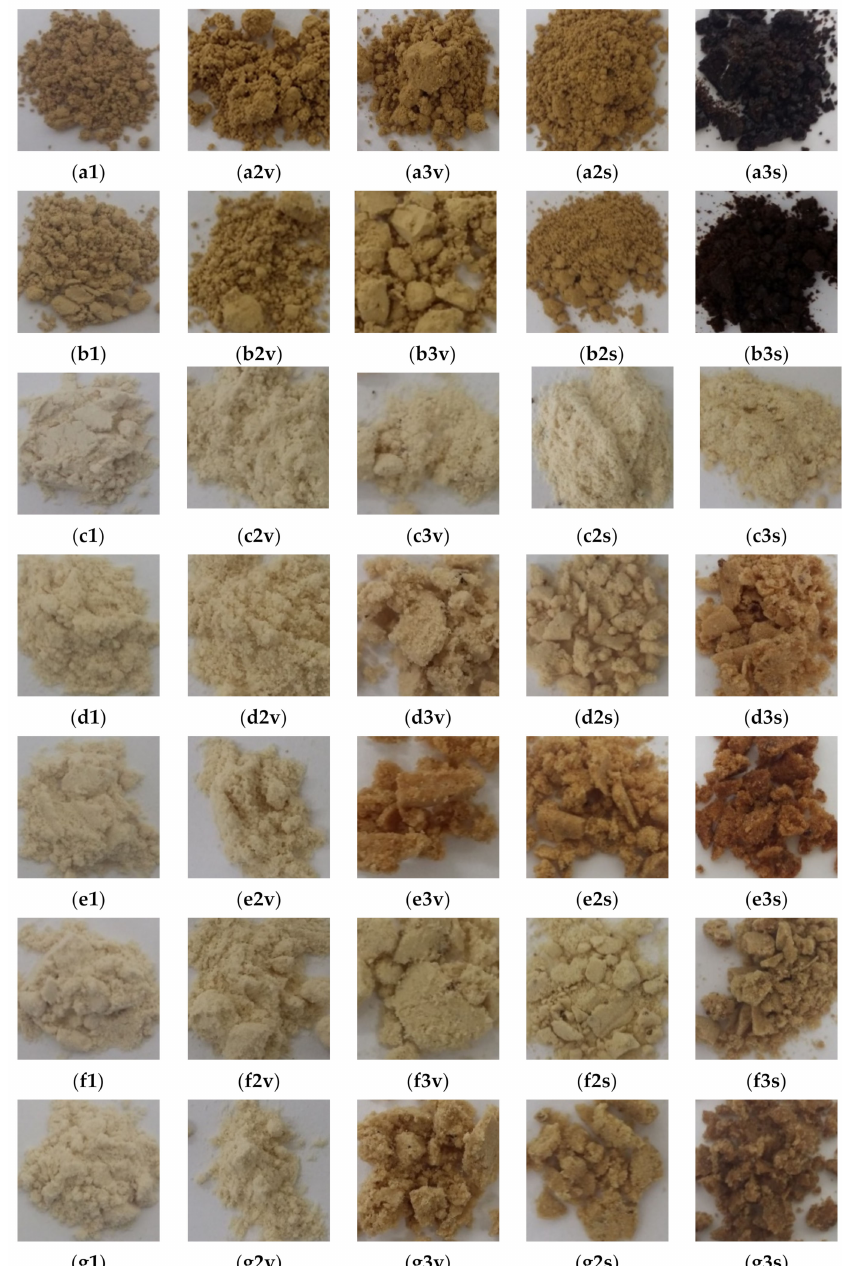
Figure 2. Change in visual appearance of the green rooibos extract powder and powder mixtures: ( a ) green rooibos extract (GRE), ( b ) GRE microencapsulated with inulin in 1:1 ratio (m/m) (IN50), ( c ) M1 (IN50 and sucrose), ( d ) M2 (IN50 and xylitol), ( e ) M3 (IN50, xylitol, and citric acid), ( f ) M4 (IN50, xylitol and ascorbic acid) and ( g ) M5 (IN50, xylitol, ascorbic acid, and citric acid), before ( 1, a1–g1 ) and after storage at 30 ◦ C/65% RH ( 2 ) and 40 ◦ C/65% RH ( 3 ) for 12 months in sealed glass vials ( v, a2v – g2v, a3v – g3v ) and 5 months in semi-permeable sachets ( s, a2s – g2s, a3s – g3s